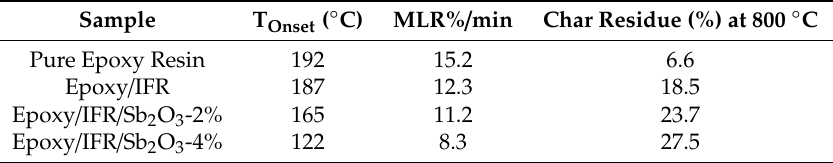
Table 3. Thermo gravimetric results of the coatings under nitrogen atmosphere. Sample T Onset ( ◦ C) MLR% / min Char Residue (%) at 800 ◦ C Pure Epoxy Resin 192